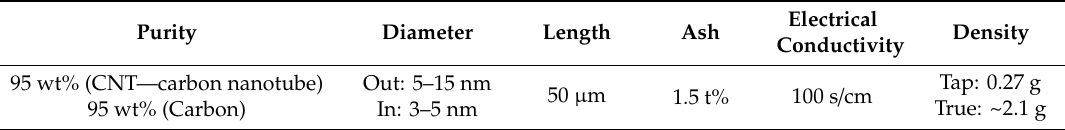
Table 1. Specification of MWCNT (multi-walled carbon